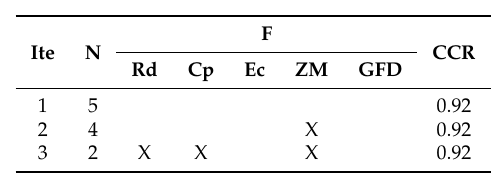
Table 6. Intra-modal selection of shape features. Correct classification rates obtained when applying selection process on breast MRI shape features. Ite: iteration. N: number of features kept. F: features. CCR: correct recognition rate.